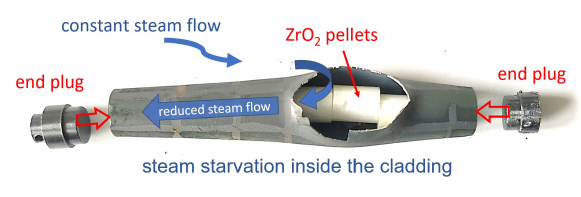
Figure 7. Schematic overview of the secondary hy- driding after burst test experiment.